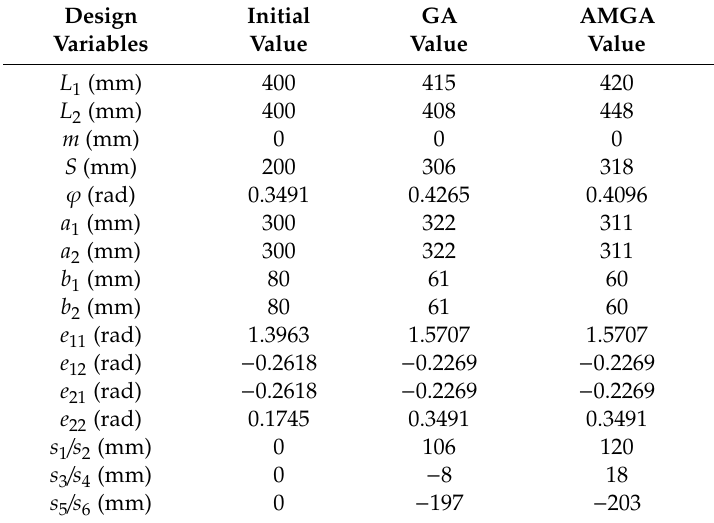
Table 4. Optimization results.